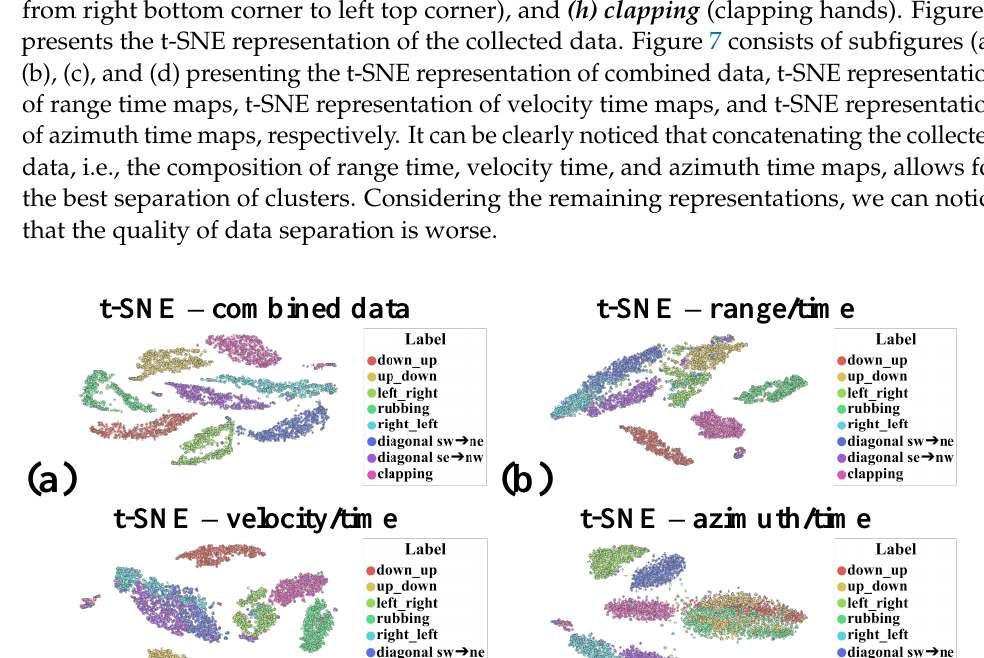
Figure 6. Generation scheme of range time, velocity time, and angle time images.